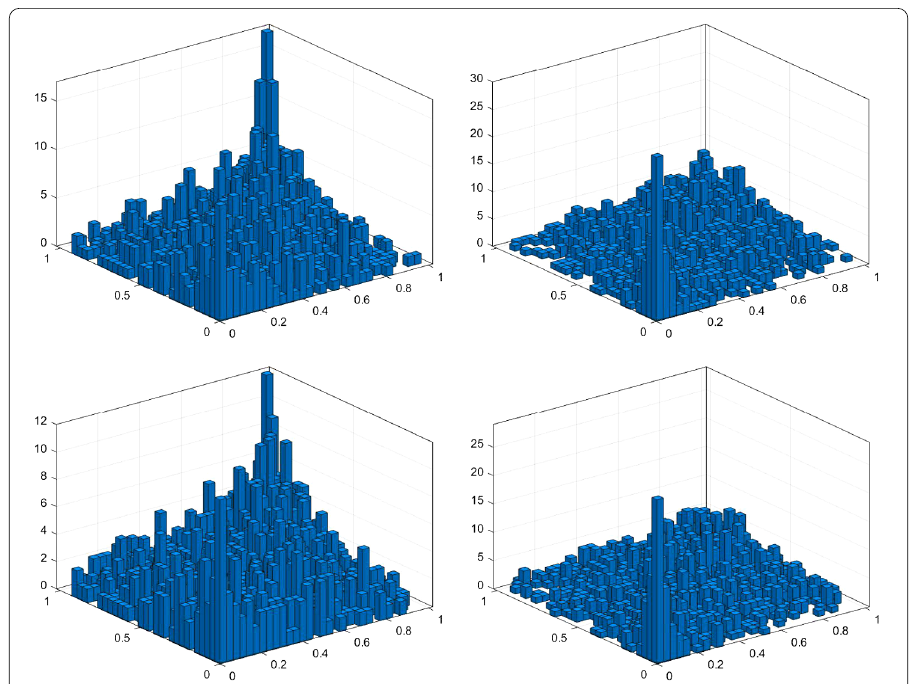
Figure 3 3d-histograms. ( a , top left): Gumbel (full data), ( b , top right): Clayton (full data), ( c , bottom left): Gumbel (censored data), ( d , bottom right): Clayton (censored